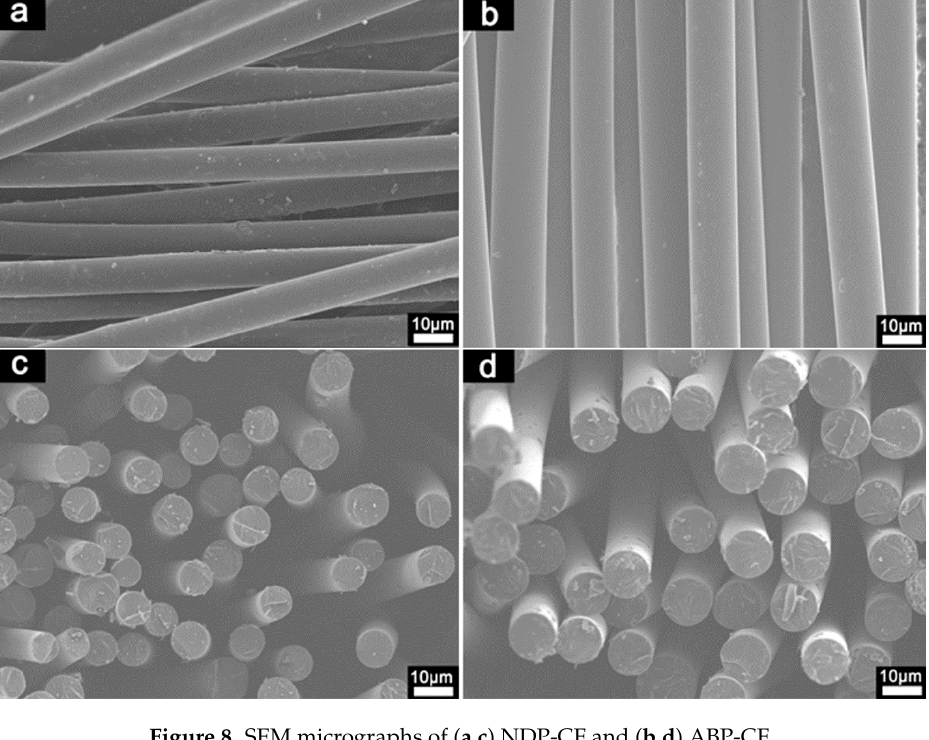
Figure 8. SEM micrographs of ( a , c ) NDP-CF and ( b , d ) ABP-CF.